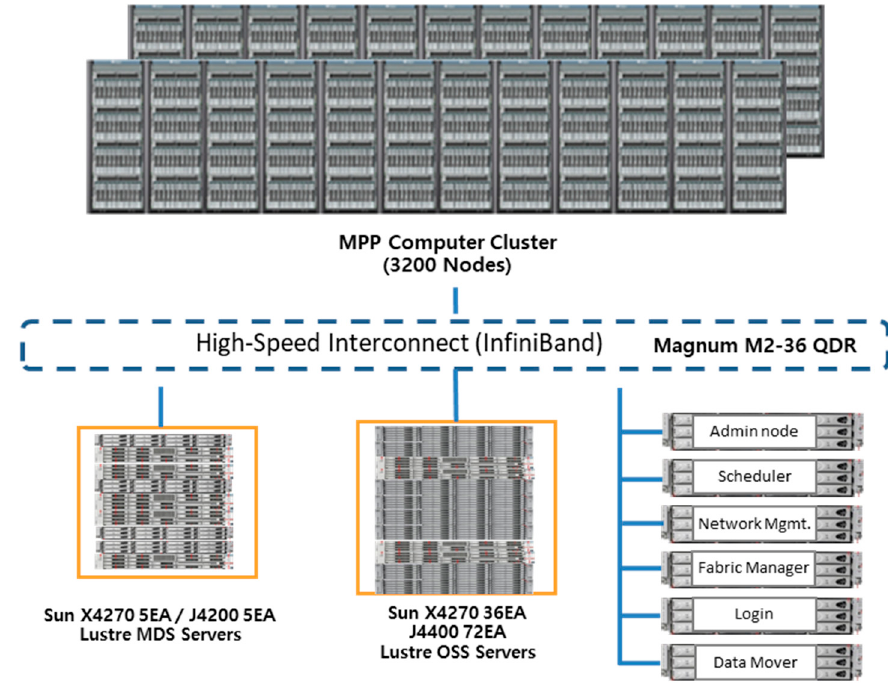
Figure 1. Diagram of KISTI’s Tachyon2 supercomputer.